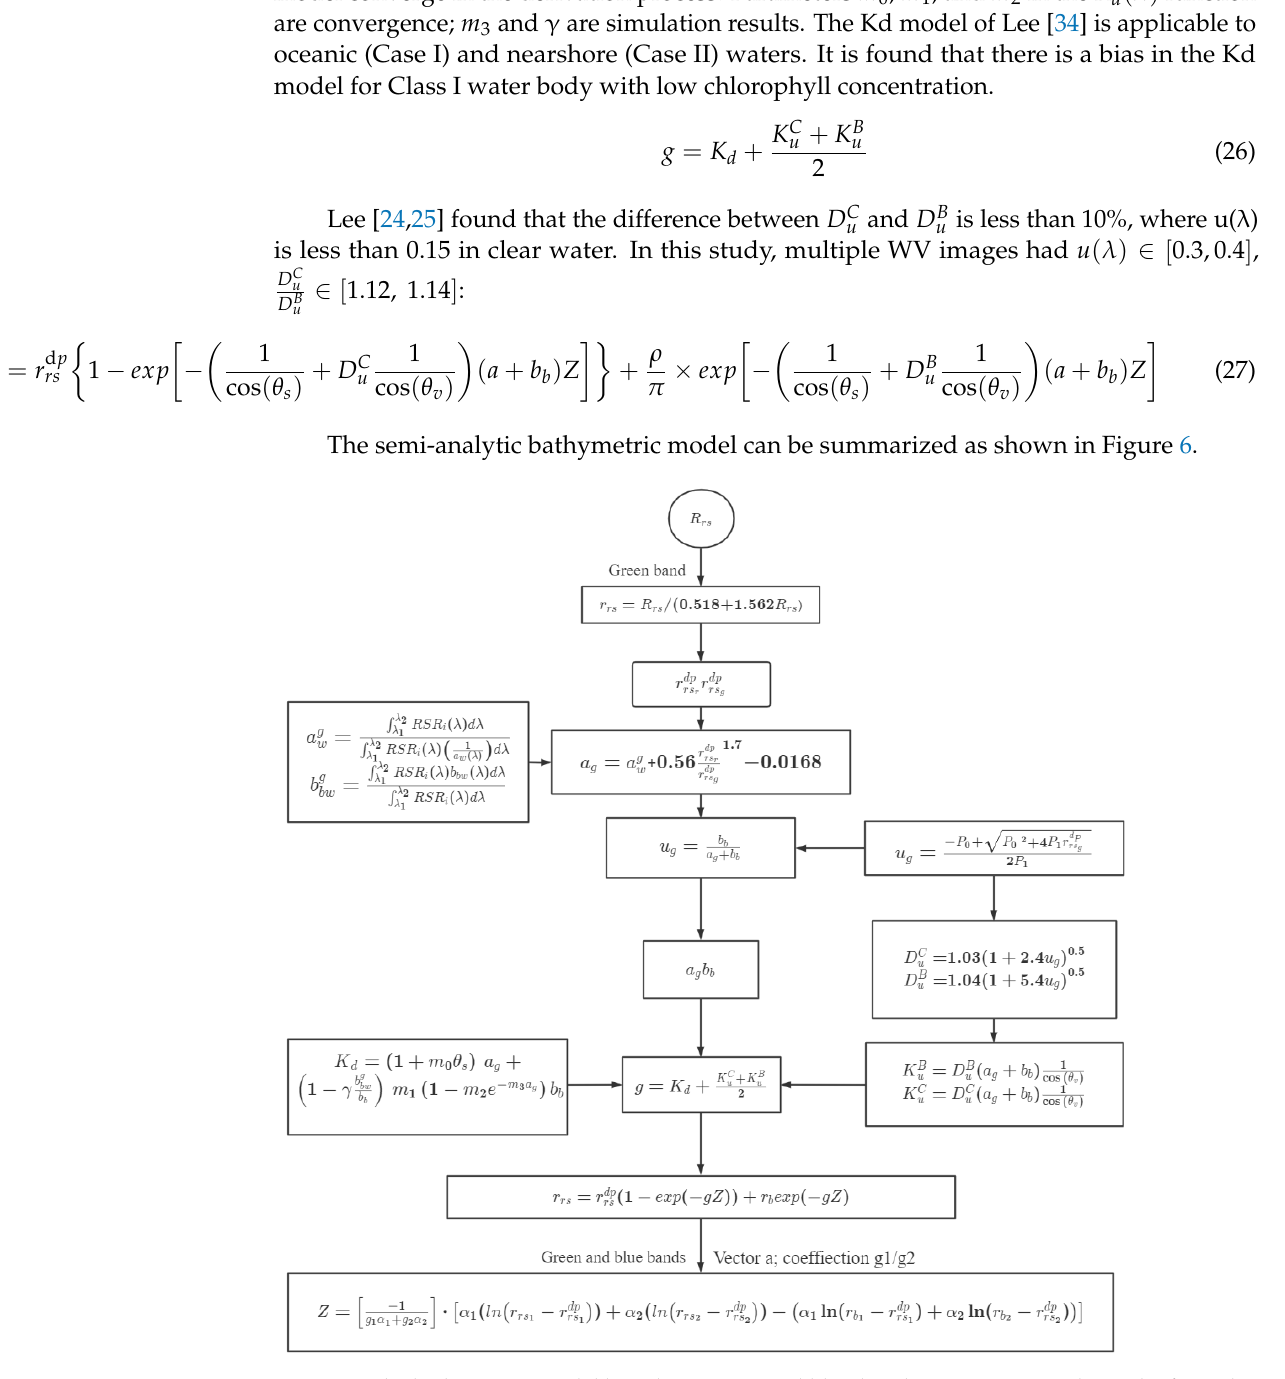
Figure 6. The bathymetric model based on green- and blue-band remote sensing data. The formulas in the rectangle are deduced by the QAA model and Kd simulations on the green band. 𝑟 𝑟𝑠 is the subsurface remote sensing reflectance. 𝑚 0,1,2,3, and γ are constant values in 𝐾 𝑑 .𝑎 𝑔 is the absorption coefficient, and 𝑏 𝑏 is the scattering coefficient. 𝑢 𝑔 is the Gordon parameter. 𝐾 𝑑 is the attenuation coefficient. 𝐷 𝑢𝐶 is the scattering factor of the water column, and 𝐷 𝑢𝐵 is the scattering factor of the underwater optical path. Subscripts 1 and 2 represent the green- and blue-bands, respectively. 𝑟 𝑟𝑠ⅆ𝑝 is the 𝑟 𝑟𝑠 value in optical deep water. Z is water depth.